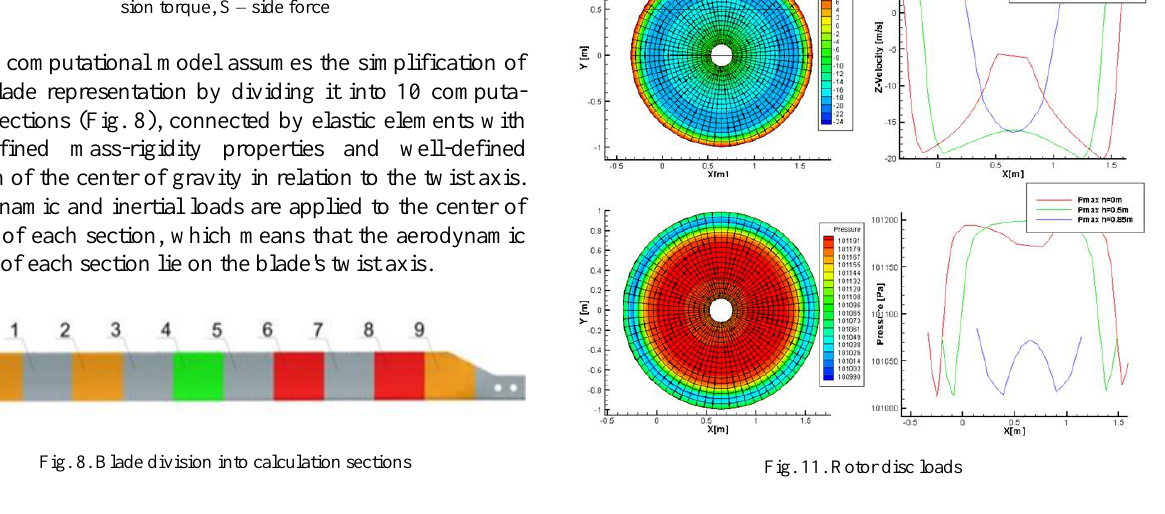
Fig. 7. Visualisation of the load distribution, T – thrust force, Q – propul- sion torque, S – side force